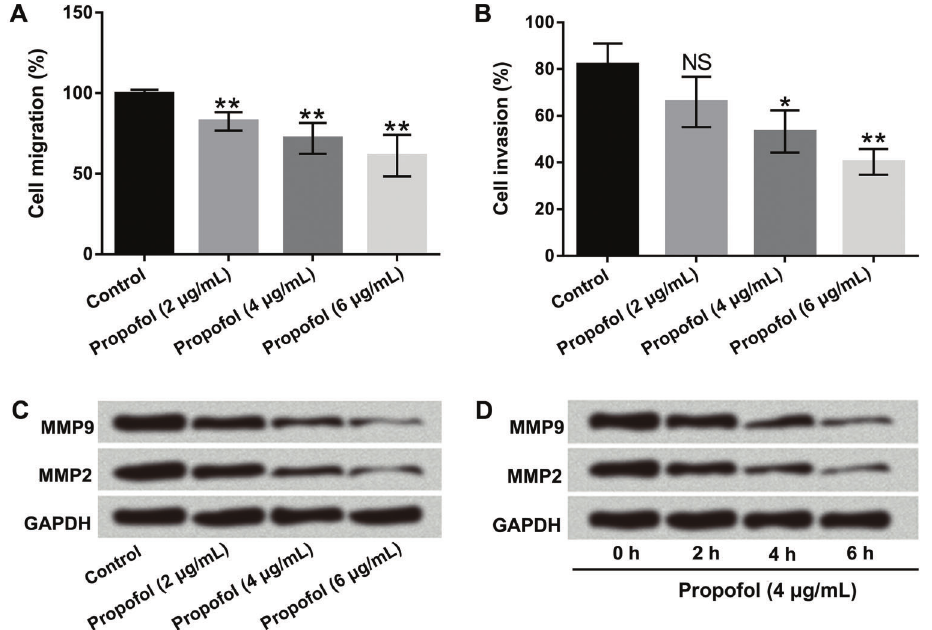
Figure 3. Propofol inhibited cell migration and invasion in Ishikawa cells. Human EC Ishikawa cell line was exposed to different concentrations of propofol (2, 4, and 6 m g/mL). After treatment for 24 h, ( A ) cell migration, ( B ) cell invasion, ( C ) and protein levels